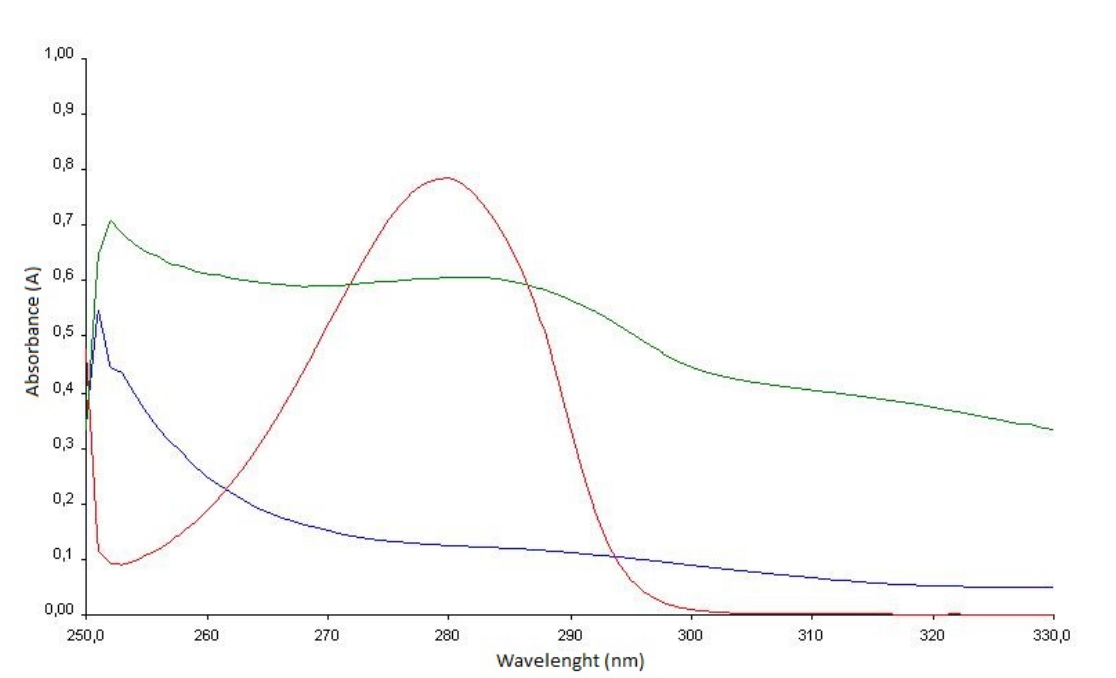
Figure 5. UV-spectra of pure DA (red); AlgOX (blue); and Alg OX-DA (green).